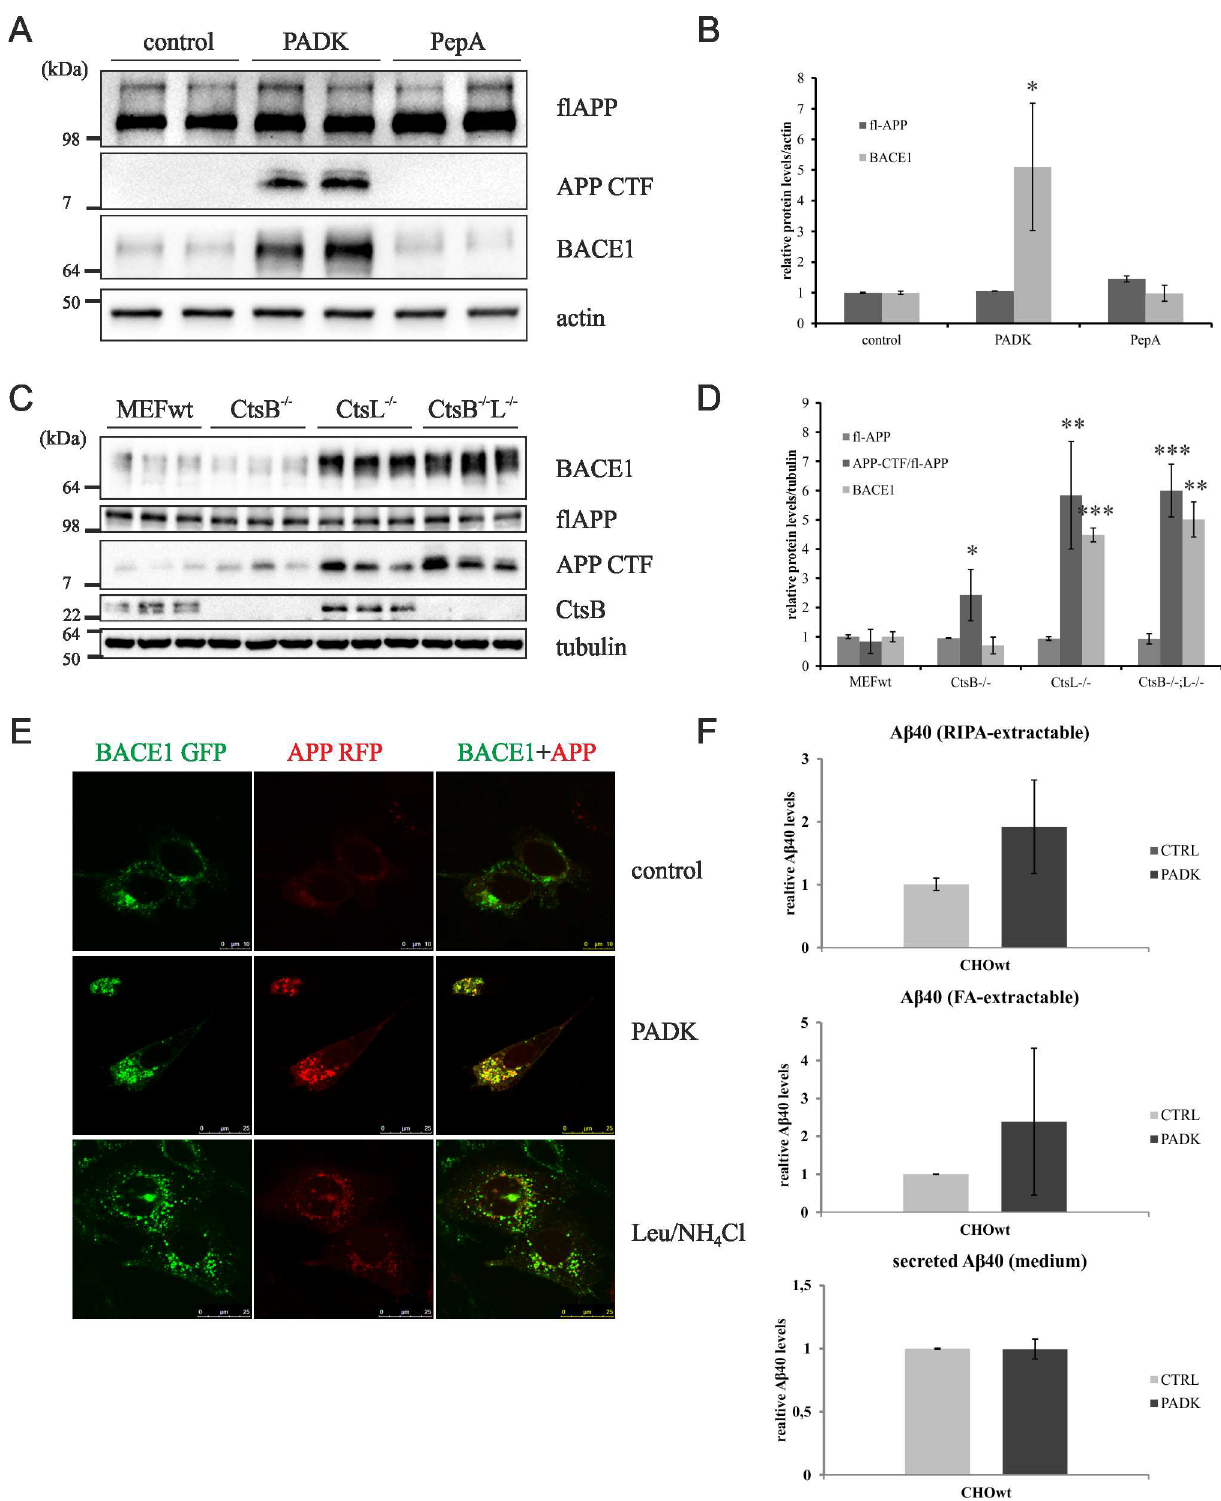
Fig 6. Cathepsin B/L are essential in lysosomal degradation of the key Alzheimer’s proteins. (A) Western blot of CHOwt cells treated with CtsB/L (PADK) and CtsD (PepA) inhibitors. Fl-APP and BACE1 were monitoredin cell lysate, APP-CTFs were immunoprecipitatedform the cell lysate. β –Actin was used as a loadingcontrol. (B) Quantification of Western blot results of the 3 independentexperiments